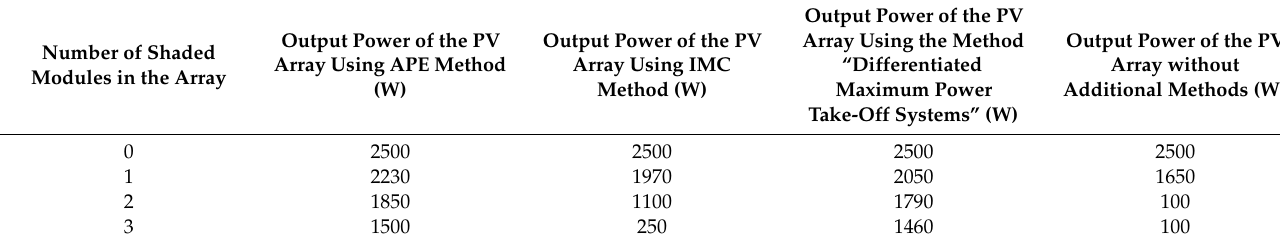
Table 2. Output power of the PV array using different